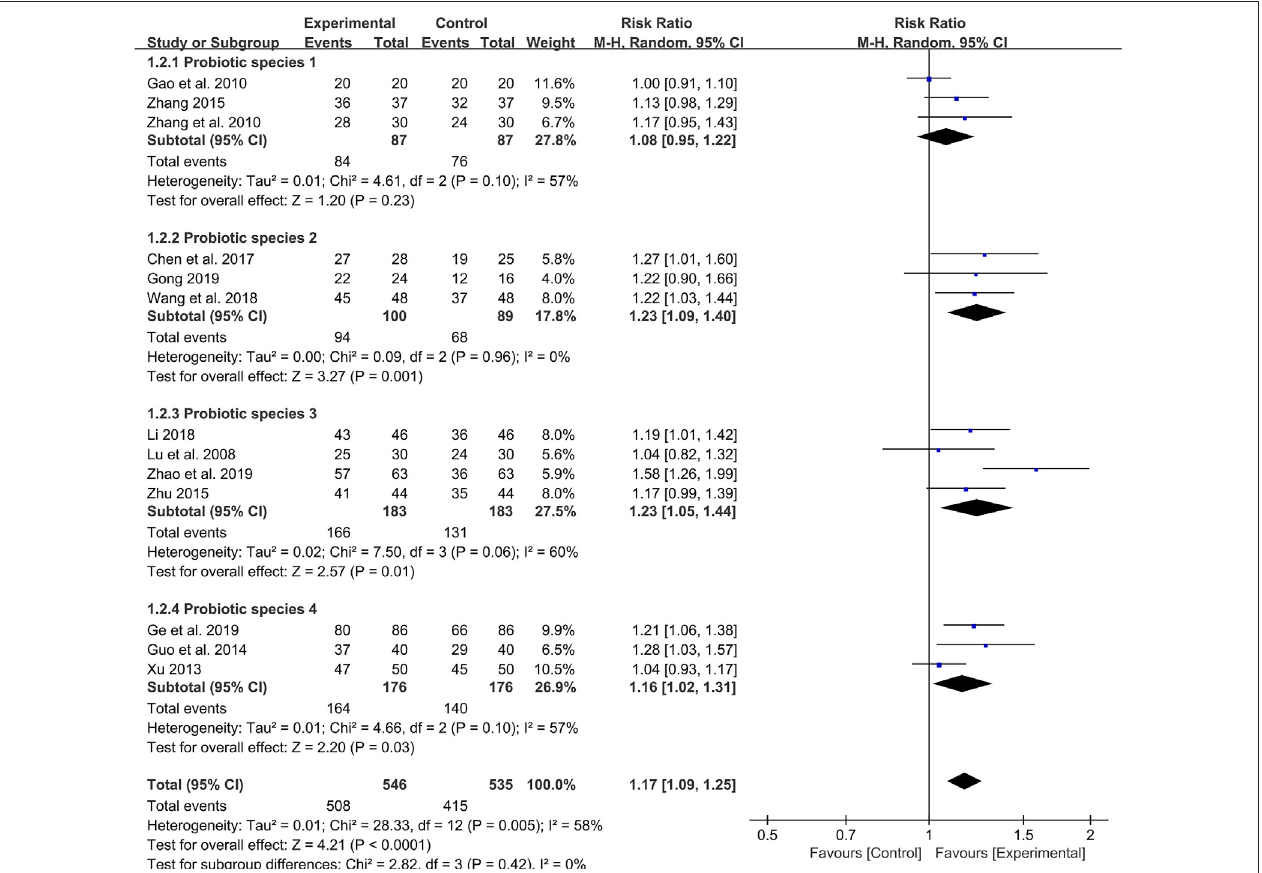
FIGURE 5 | Forest plot displaying the results of the meta-analysis for clinical effective rate in different probiotics species used.